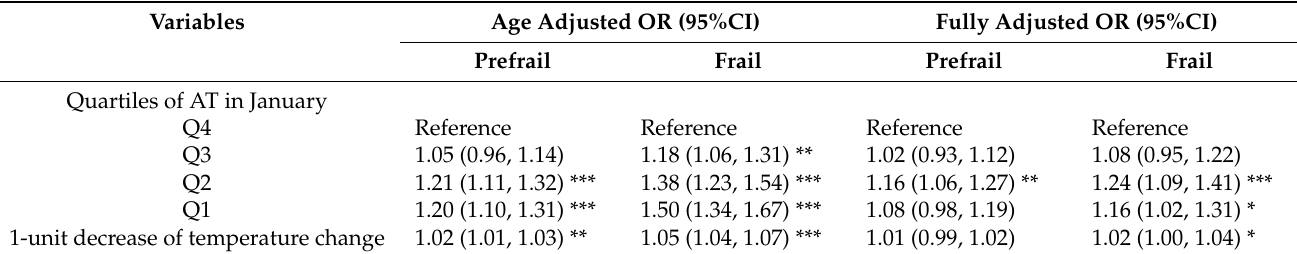
Table 3. GLMM analysis for the associations between temperature change and frailty.